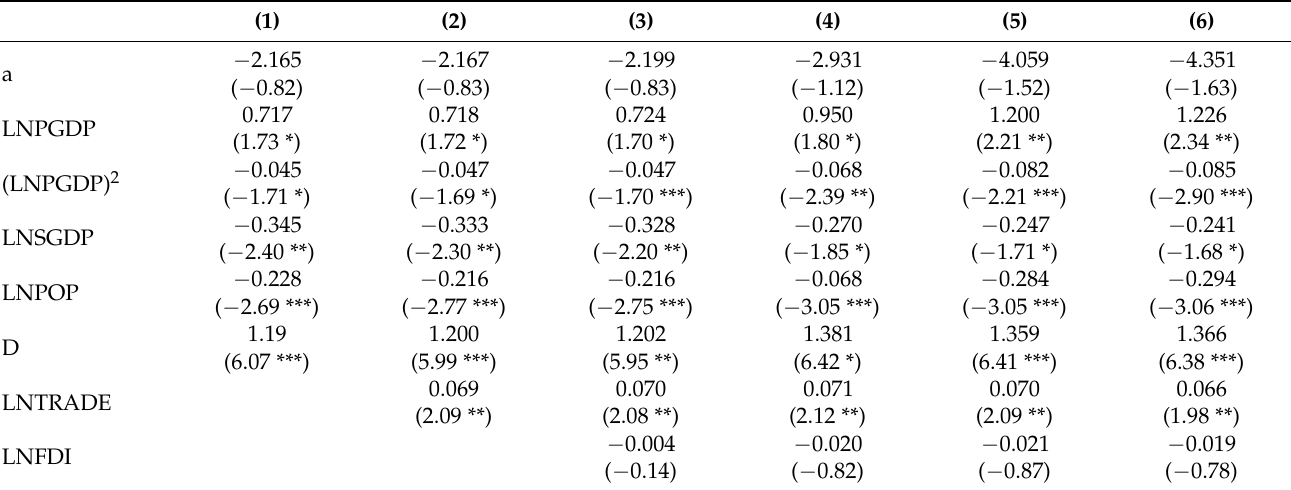
Table 6. Estimation results for tobit